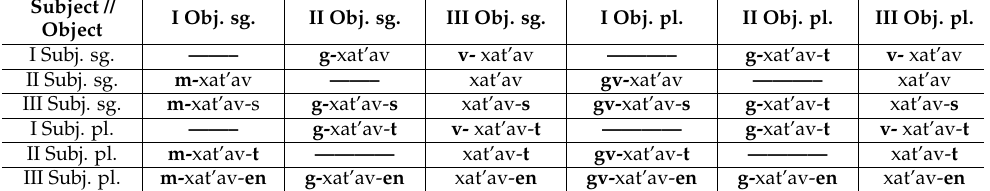
Table 6. Verb forms in the Present tense ( khat’avs ).